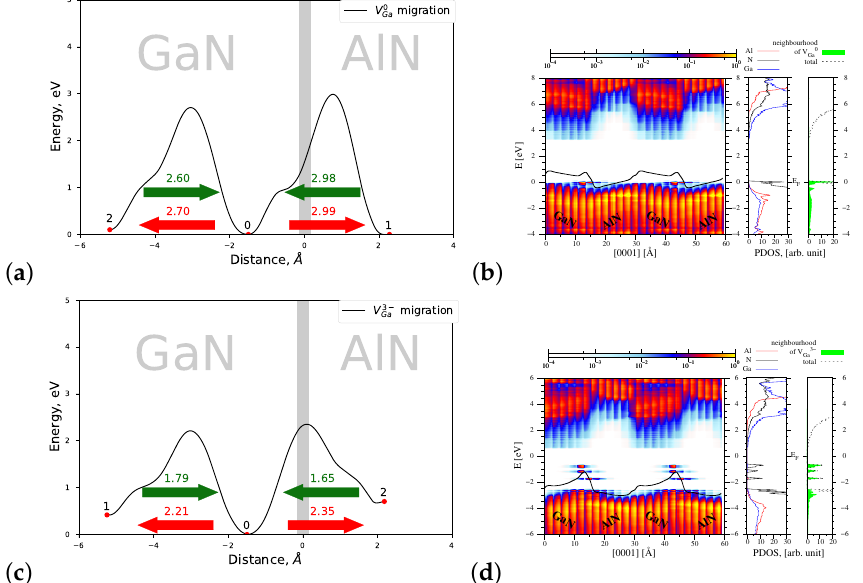
Figure 7. Left—joint profiles of the migration energy barrier of gallium vacancy V Ga at the AlN/GaN strained interface type, right—the density of states projected on the atom quantum states (PDOS), showing the spatial variation of the valence and conduction bands in the GaN/AlN heterostructure, as well as the total DOS and PDOS functions associated with Al, N, and Ga atoms, denoted by red, black, and blue lines, respectively. The green shade represents a sum of the PDOS from the nearest neighbors of V Ga . ( a , b ) V 0 , the corresponding potential jump ∆ V = 0.99 eV ( c , d ) V 3 − Ga the corresponding potential jump ∆ V = 1.35